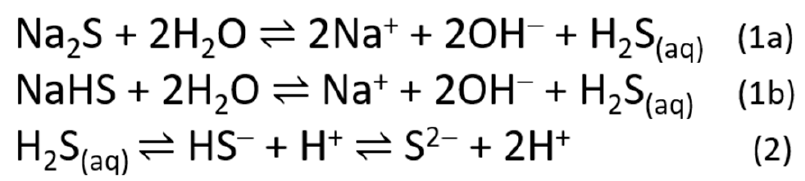
Figure 2. Mechanism of H 2 S release from Na 2 S ( 1a ) and NaHS ( 1b ) in aqueous solution and its dynamic equilibrium among different species ( 2 ).